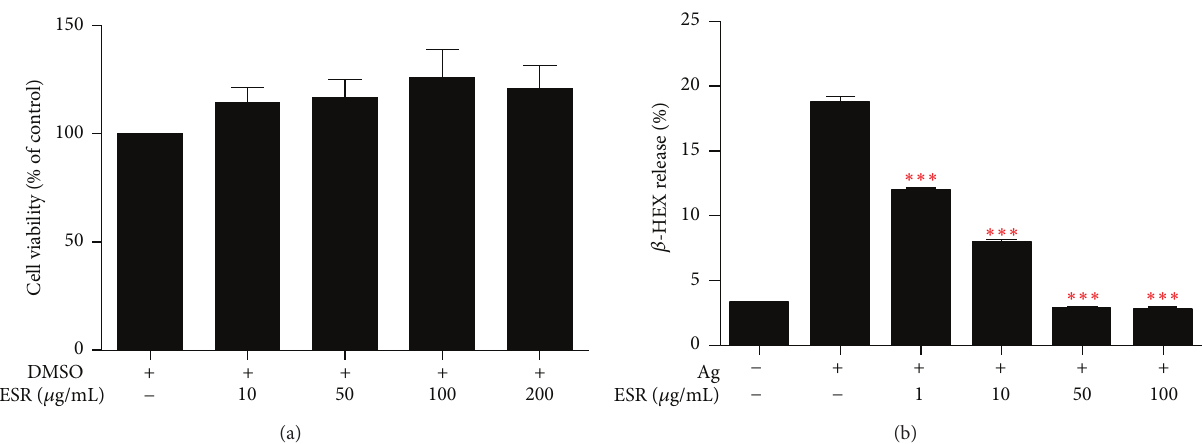
Figure 5: Effects of ESR on cytotoxic and mast cell degranulation in BMMCs. (a) Cytotoxicity of BMMCs was determined using a CCK assay. BMMCs were seeded into 96-well plates and treated with various concentrations of ESR for 24 h. (b) Inhibitory effects of ESR on 𝛽 - HEX release in BMMCs. BMMCs were sensitized overnight with anti-DNP IgE and challenged with DNP-HAS (Ag) with or without ESR. The data are presented as the mean ± SEM of three independent experiments. ∗∗∗ 𝑝 < 0.001 versus